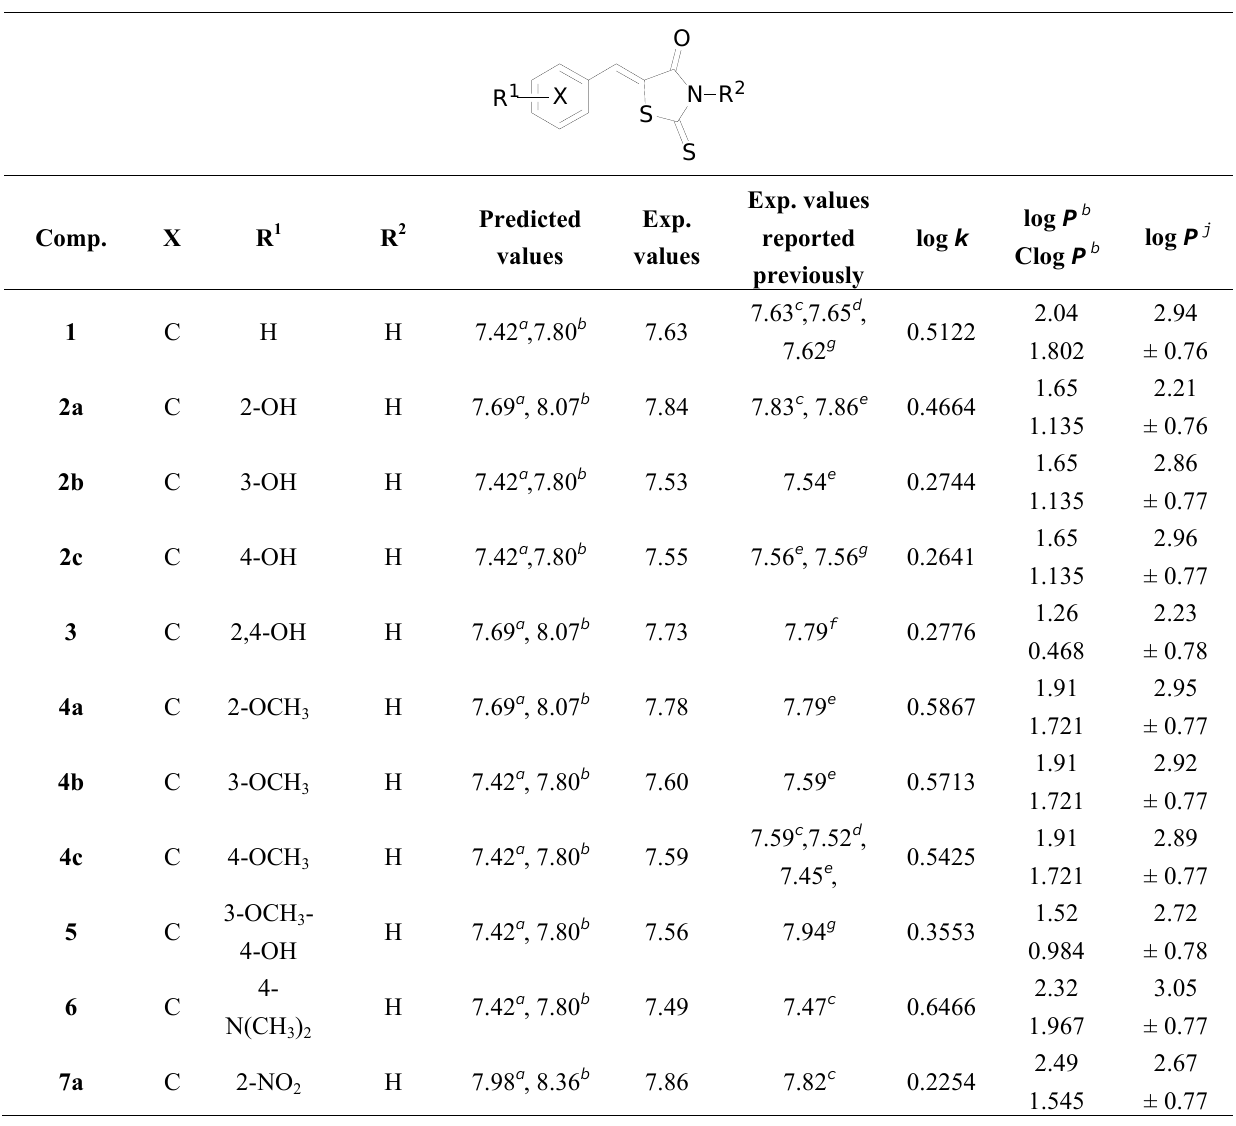
Table 1. Comparison of 1 H-NMR signals of methine-group for Z -isomers and comparison of calculated lipophilicities (log P , Clog P ) with determined log k values of compounds.